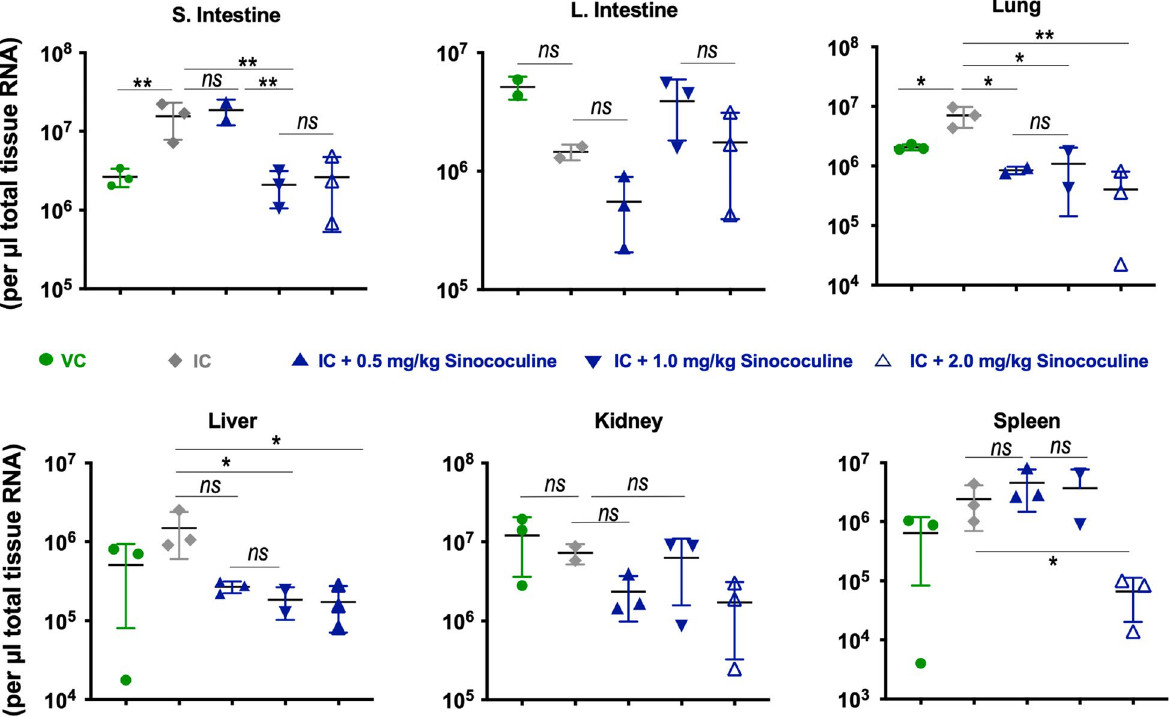
Figure 4. Sinococuline effectively reduces dengue virus load in several organs of severely DENV-infected AG129 mice. Group of AG129 (n = 3) inoculated with IC and treated with different doses of Sinococuline (i.p), viz., 0.5 mg/kg/day, 1.0 mg/kg/day and 2.0 mg/kg/day, in a BID manner for 4 days. On day-4 (post completion of dosing), mice were euthanised by CO 2 inhalation followed by cervical dislocation, and extensively perfused with 1× PBS. The vital organs were collected (50 mg each organ) in 500 µl of RNA stabilising solution. Virus load in different organs (small intestine, large intestine, lung, liver, kidney and spleen) were estimated by SYBR green-based RT-qPCR. Data were normalised from the only Sinococuline control group (uninfected mice who received highest dose of Sinococuline i.e., 2.0 mg/kg/day; BID) which was considered as the baseline. */** indicates statistically significant and ns : not significant across all the panels while data were analysed by using Two-way ANOVA with GraphPad Prism